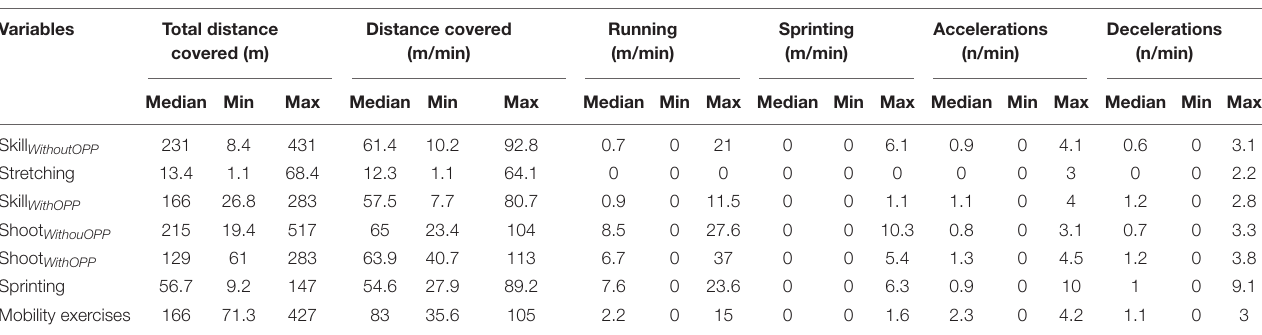
FIGURE 2 | Violin plots of the descriptive analysis. Medium horizontal line represents the median. The lower and upper horizontal lines correspond to the first and third quartiles (the 25th and 75th percentiles). SkillWithouOPP, skill without opposition; S, stretching; SkillWithOPP, skill with opposition; Shoot WithoutOPP, shooting without opposition; ShootWithOPP, shooting with opposition; Spr, sprinting; ME, mobility exercises. TABLE 3 | Descriptive analysis of each